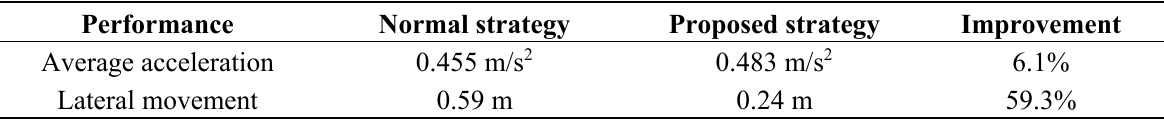
Table 4. Performance of acceleration slip regulation on low friction road